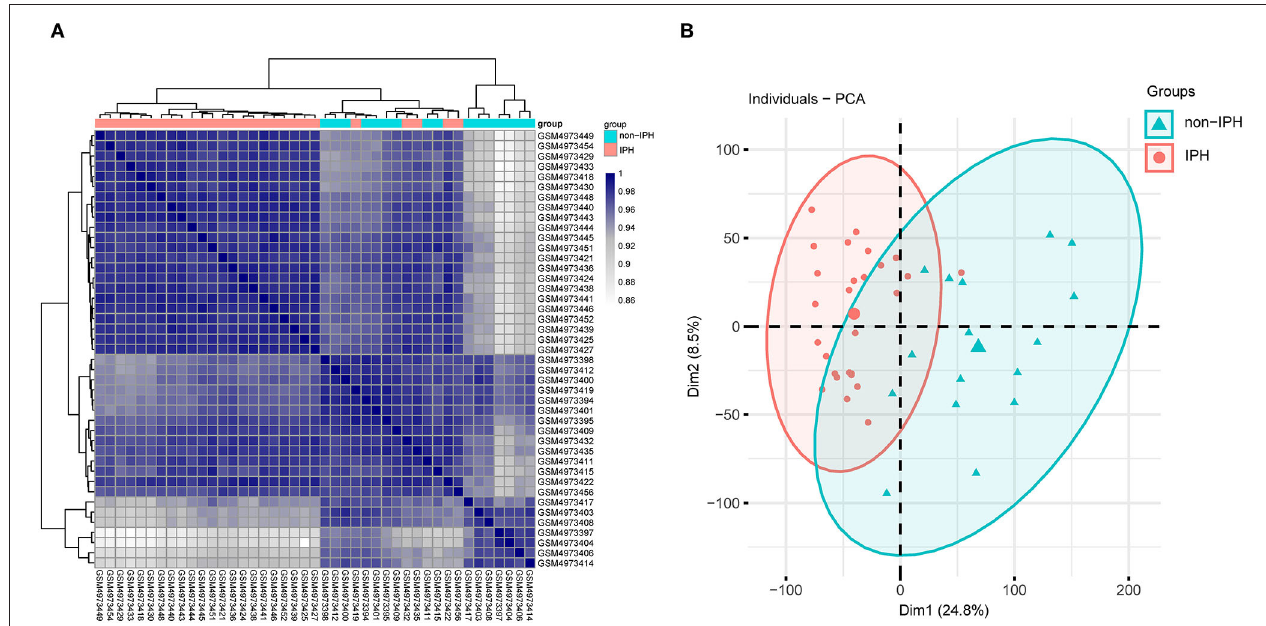
FIGURE 2 | Validation of the dataset GSE163154 by Pearson’s correlation analysis and PCA. (A) Pearson’s correlation analysis of samples from the GSE163154 dataset. The correlation coefficient is reflected by the colors in the heatmap. (B) PCA of samples from the GSE163154 dataset. PC1 and PC2 are represented on the x-axis and y-axis, respectively. PCA, principal component analysis; PC1, principal component 1; PC2, principal component 2.